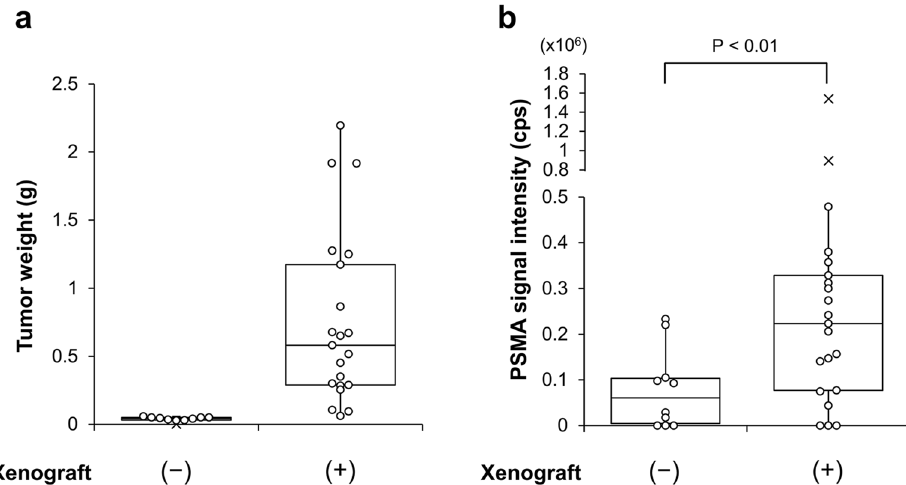
Figure 5. Measurement of the PSMA-EV levels in serum of mouse xenograft model for PC. The C4-2B PC cells were injected into the subcutaneous space of athymic nude mice. After the formation of tumor, blood was collected and the xenograft tissues were removed from control (n = 10) and xenograft mice (n = 21). ( a ) The tumor weight was measured. ( b ) The PSMA-EV levels in serum was determined after purification of EVs from serum by Tim4. Data are shown in the ’box and whiskers’ graph with interquartile range (IQR: box), median (thick vertical line in the box) and 1.5 IQR (whiskers). x denotes